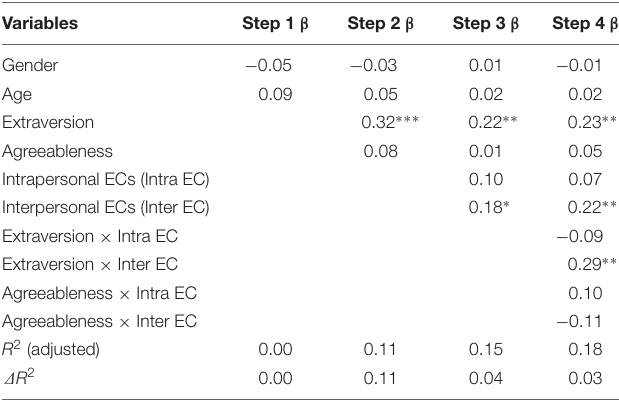
TABLE 2 | Results of the moderated hierarchical regression analyses on the influence of extraversion, agreeableness and emotional competence on peer-rated